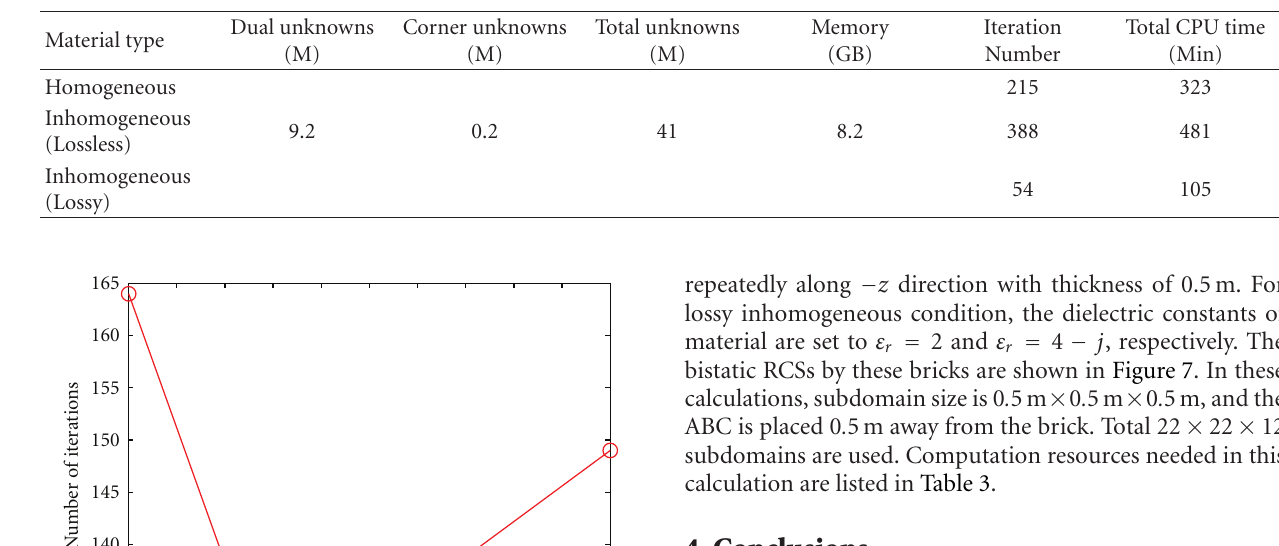
Table 3: Computation resources for the large dielectric brick.